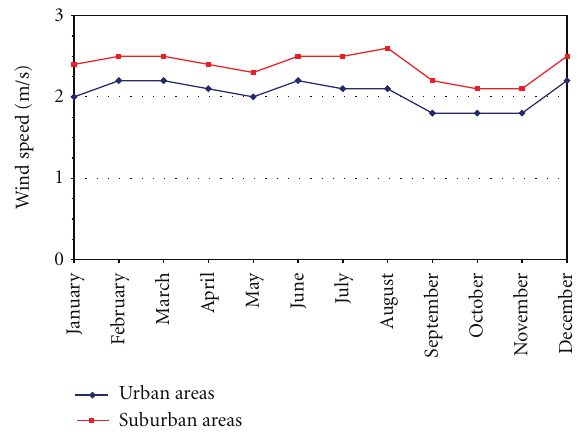
Figure 2: Annual variation of mean maximum monthly temper- ature for the urban and suburban areas within the GAA. Period 2001–2005.